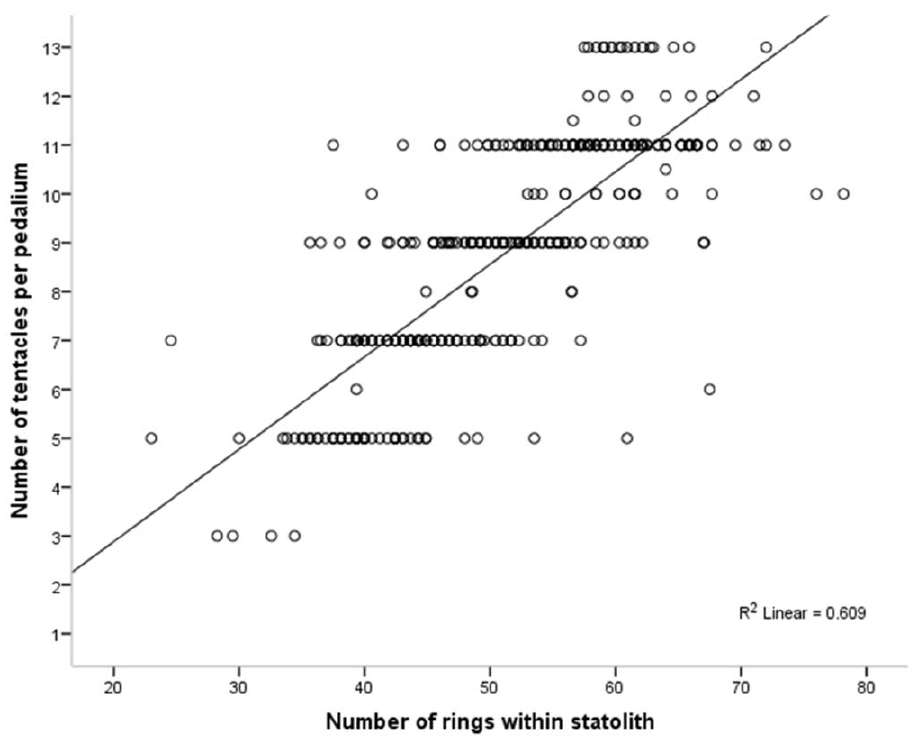
Figure 4. Positive linear relationship between number of rings and number of tentacles for Chironexfleckeri medusae. Number of rings is the average per statolith and tentacle number is per pedalium.